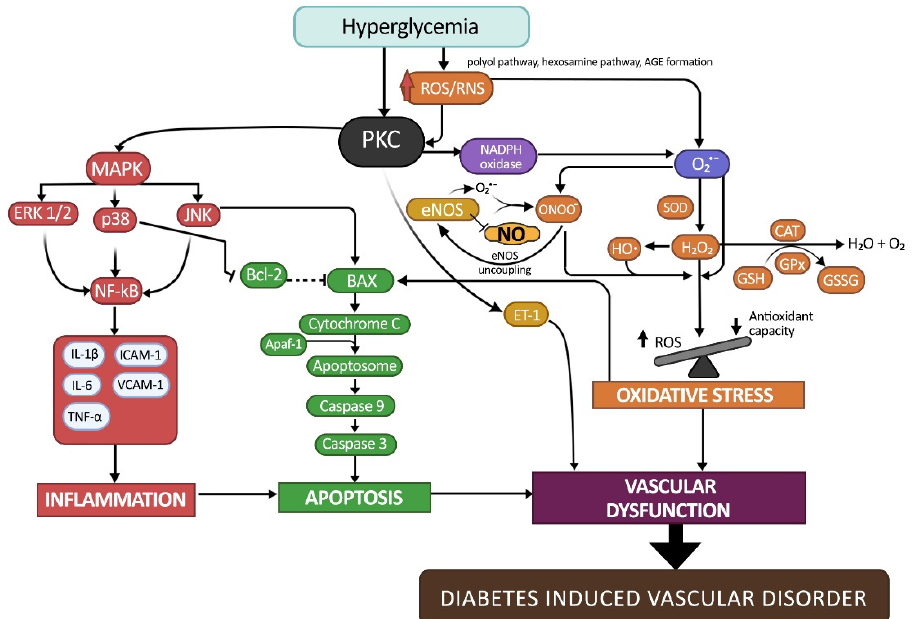
Figure 2. A summary of the genes implicated in DM-induced vascular disorder development. Hyperglycemia resulting from insulin dysregulation induces overproduction of ROS and RNS, generating oxidative stress in the vascular cell. PKC pathways induce inflammation and apoptosis via MAPK pathways. Uncontrolled cellular deaths, as well as oxidative stress, lead to cardiac vascular dysfunction and progress to DM-induced vascular disorder.